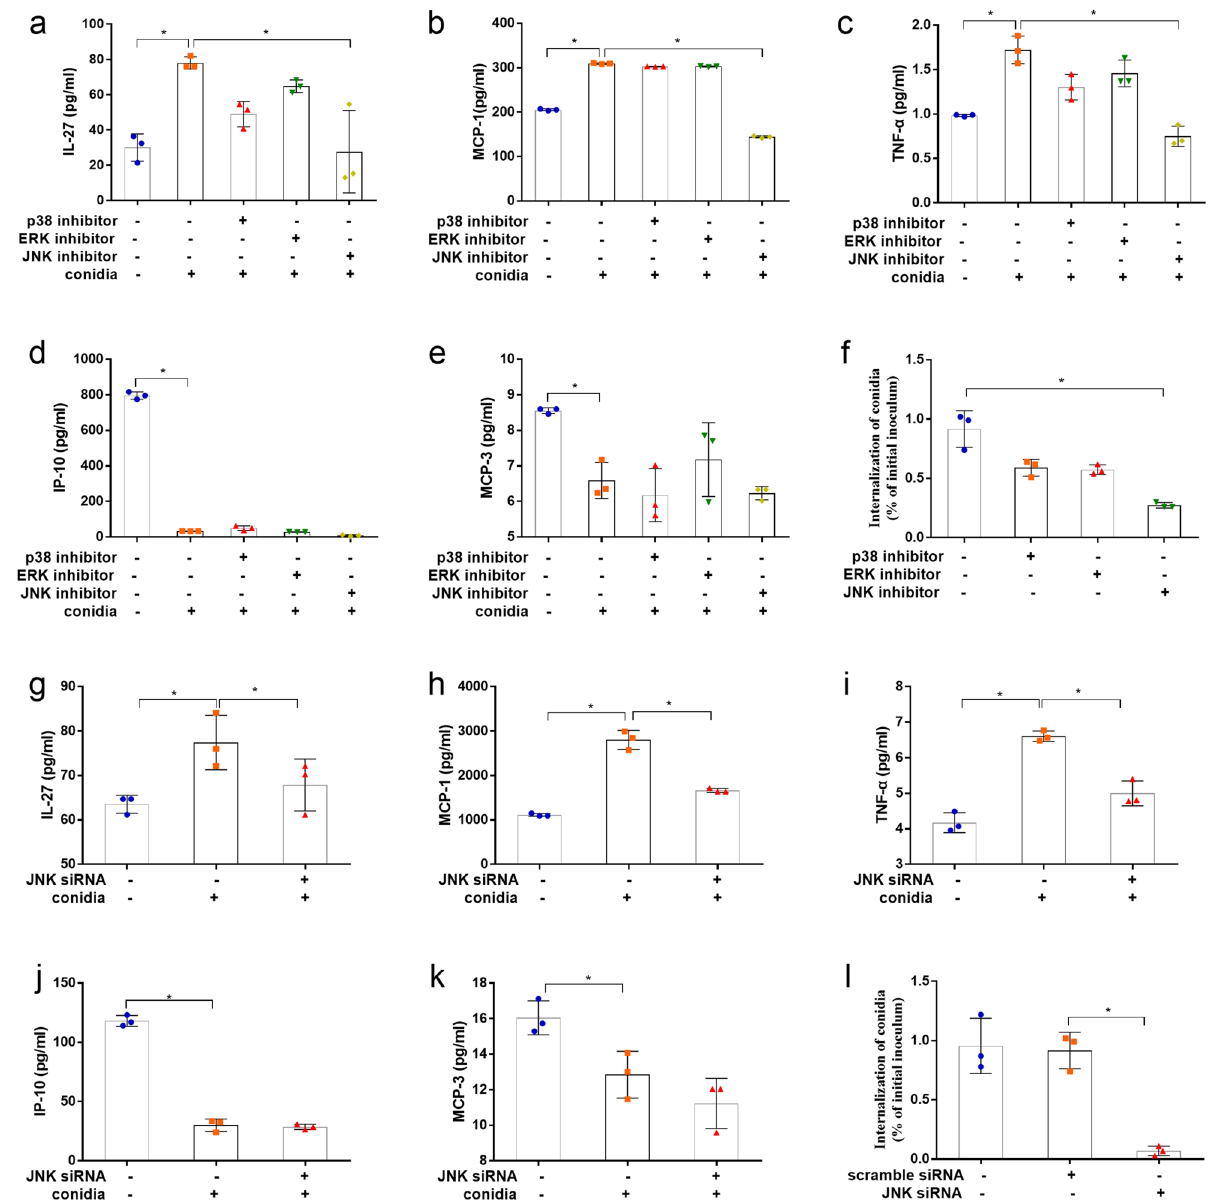
Figure 3. Involvement of JNK signaling pathway in internalization of A. fumigatus and release of cytokines. Prior to inoculation with A. fumigatus conidia for 8 h, BEAS-2B cells were treated with 20 μmol p38